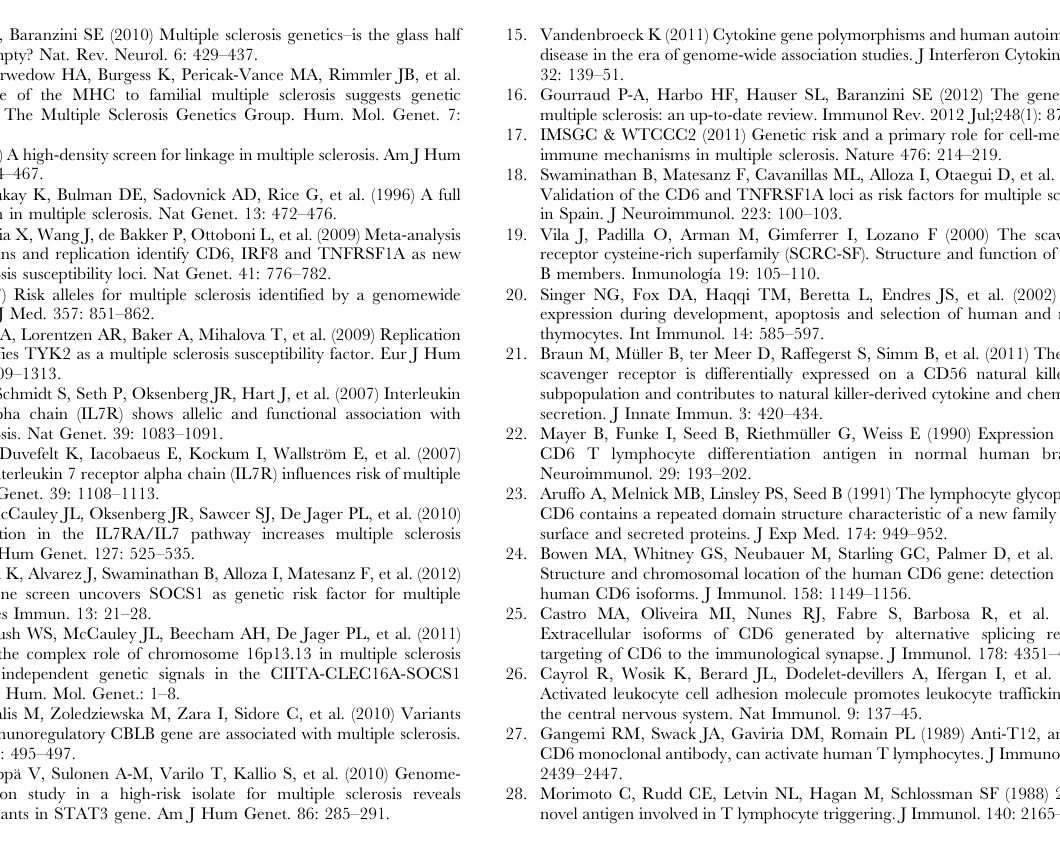
Table S2 Details of the monoclonal antibodies used in flow cytometry. Table S3 The combination of monoclonal antibodies used for cell surface staining. Table S4 OMNIBUS association P -values of haplotypes gener- ated using sliding window or multiple marker analysis on the merged datasets. Table S5 Comparison of the haplotype frequencies in the four datasets of (A) the 2 associated NS haplotype SNP markers, or (B) three NS SNP markers. Table S6 Logistic regression analysis on the combined dataset showing additive effects of the SNPs when conditioned to rs11230563, rs2074225 and